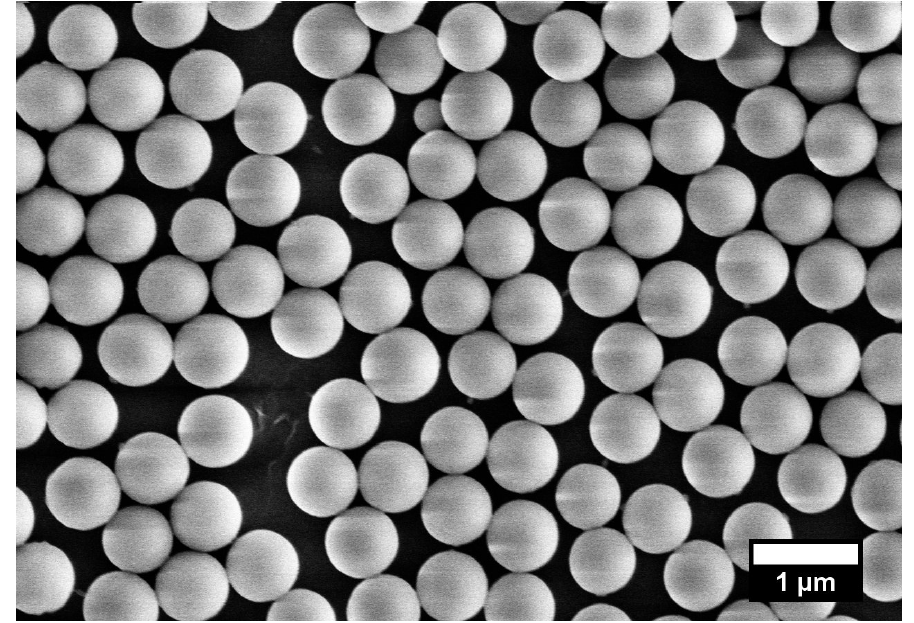
Figure A1. SEM image of SiO 2